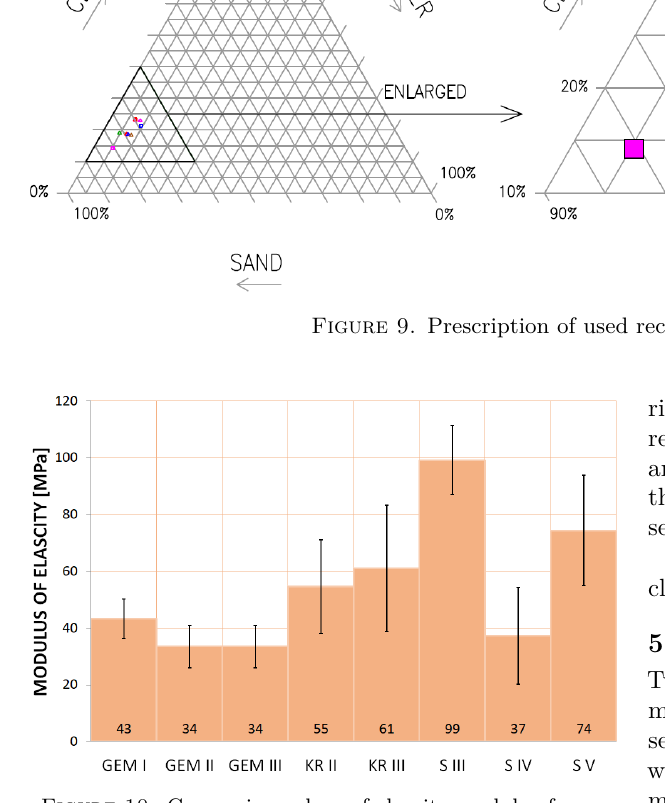
Figure 10. Comparing values of elascity modulus for all